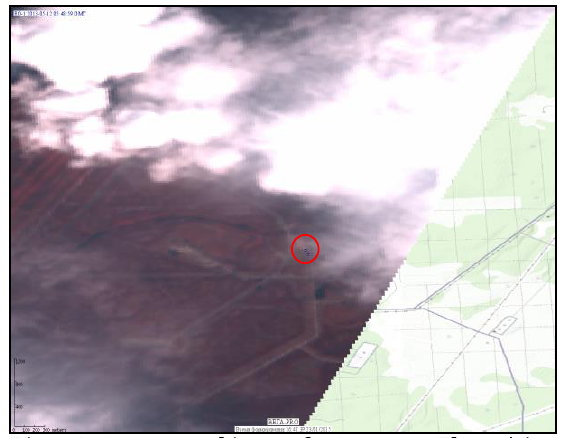
Figure 9. Hyperspectral image of a Permanent Flares object (red circle) obtained from EO-1 (20.05.13, Western Siberia).